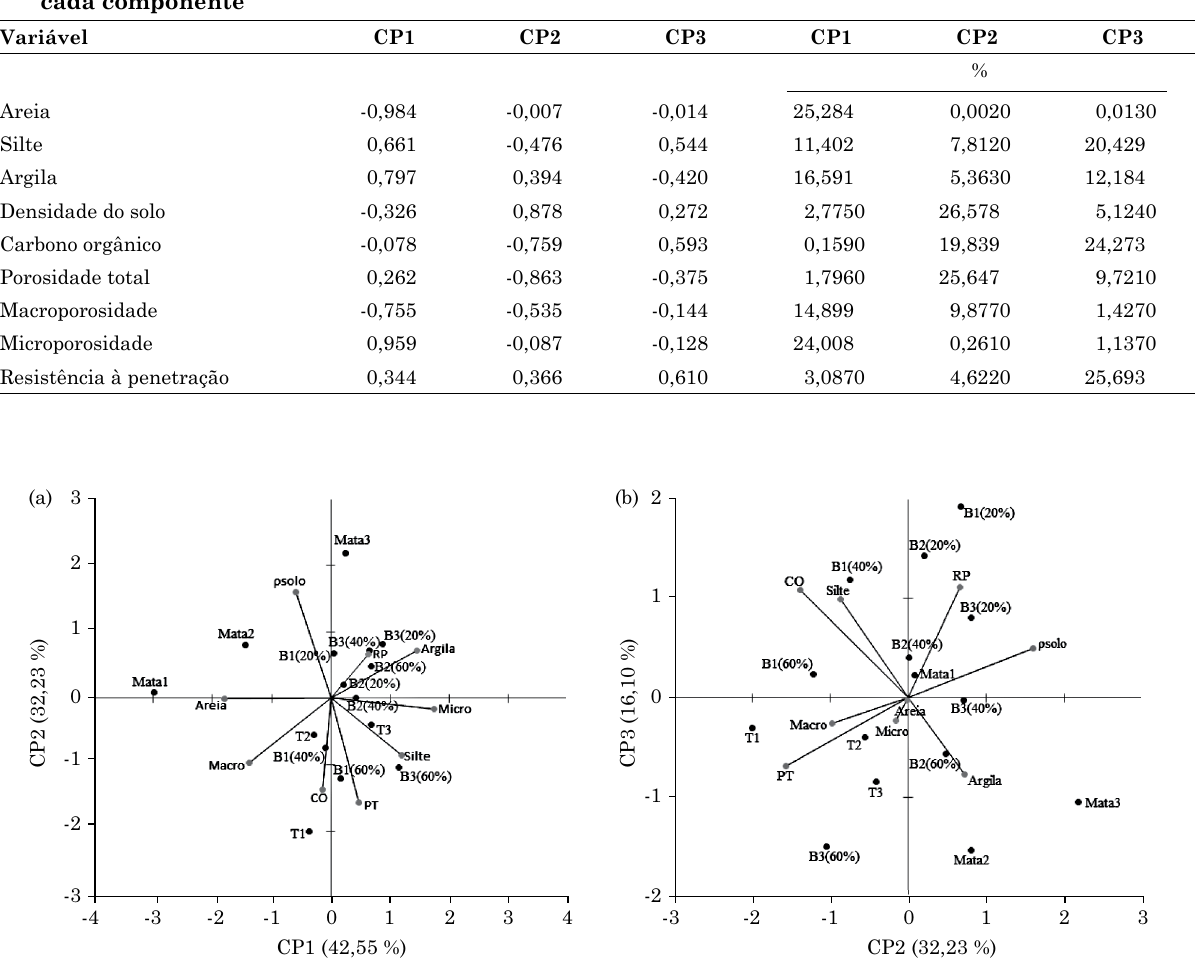
Figura 9. Dispersão dos atributos físicos para as áreas sob cultivo de figo e mata secundária nas camadas de 0,0-0,1; 0,1-0,2 e 0,2-0,3 m, sendo (a) para componentes principais 1 e 2, (b) para